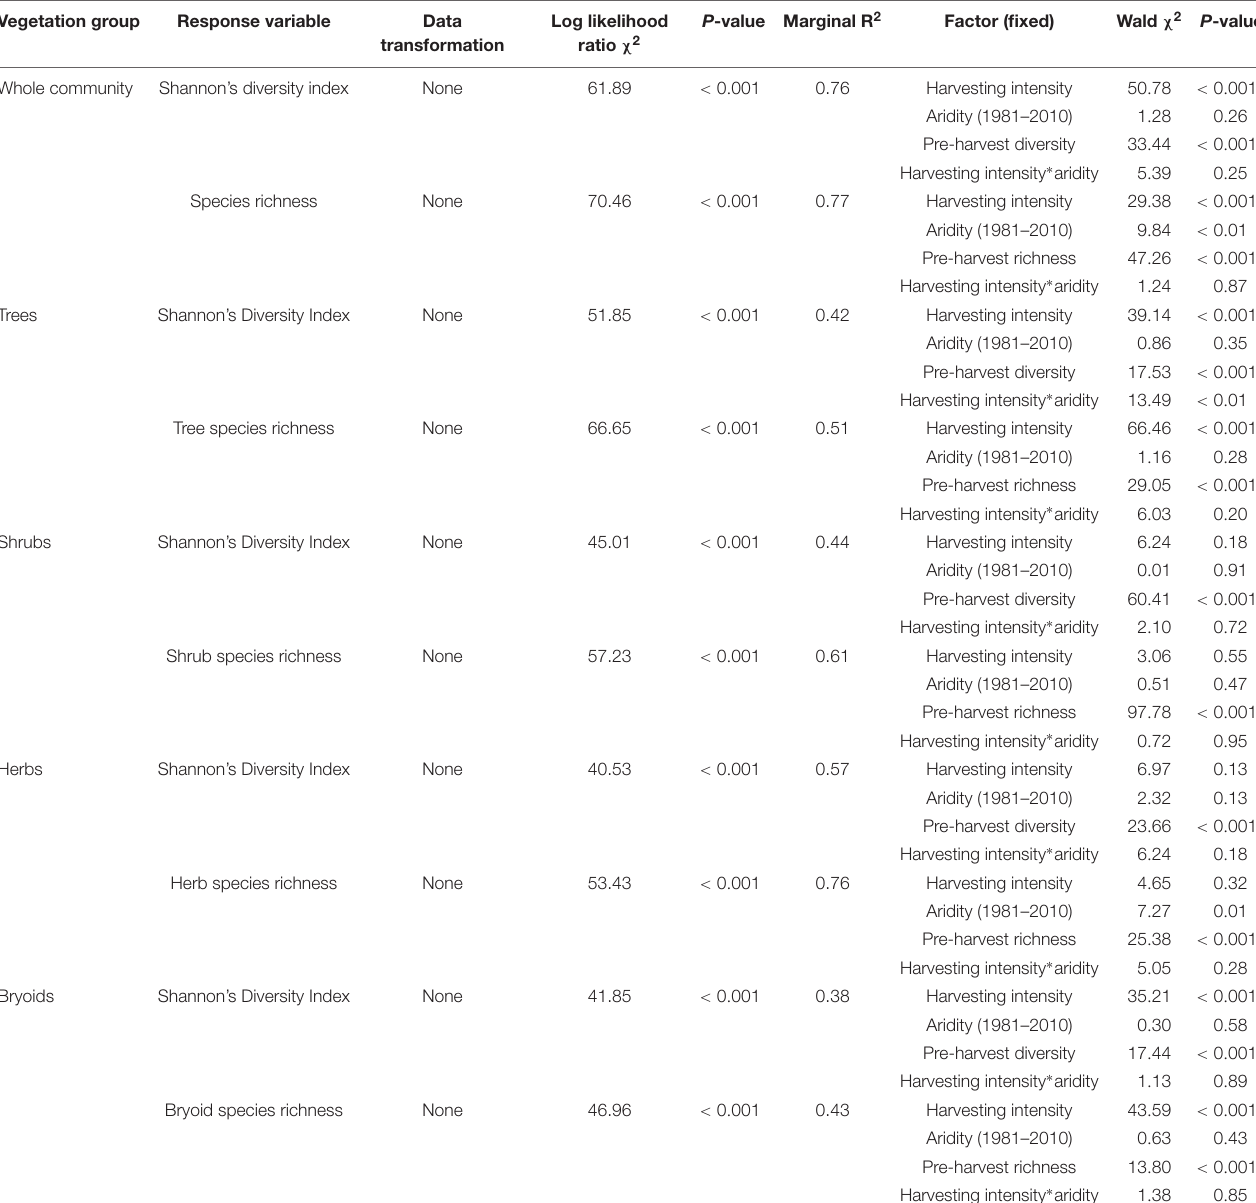
TABLE 4 | Effect of harvesting intensity and climatic aridity (1981–2010) on Shannon’s diversity index and species richness of Douglas-fir dominated forests ( n = 3 for all locations, except Narrows Creek where n = 1, and Alex Fraser where n = 2). Vegetation